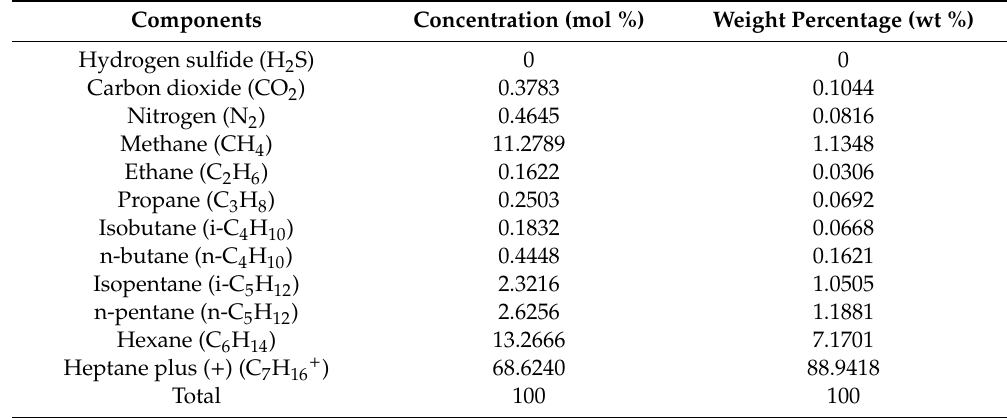
Table 1. Components of crude oil sampled at the target reservoir planned to conduct